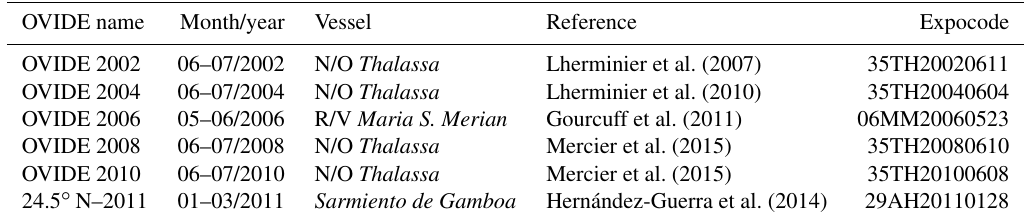
Table 1. References of cruises used in this